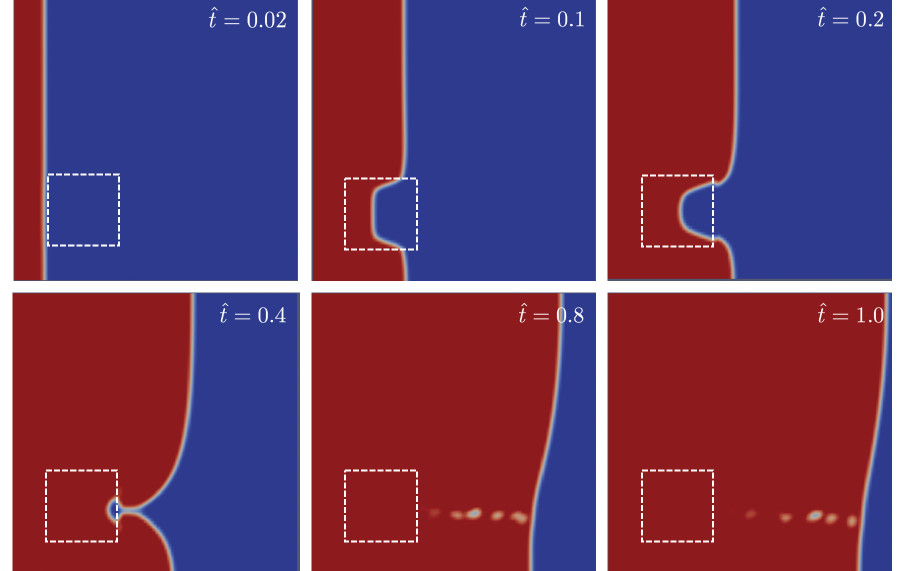
3 sensor network × 2, 3 3 and 4 4. × × ×